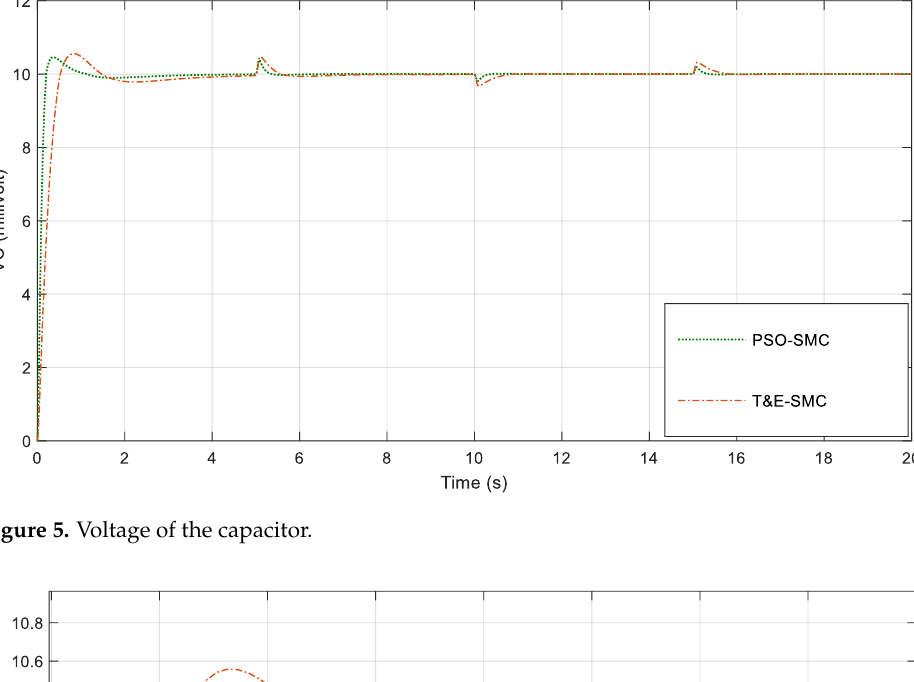
Figure 5. Voltage of the capacitor. For greater clarity, in Figures 6 – 9, various points of Figure 5 are enlarged.